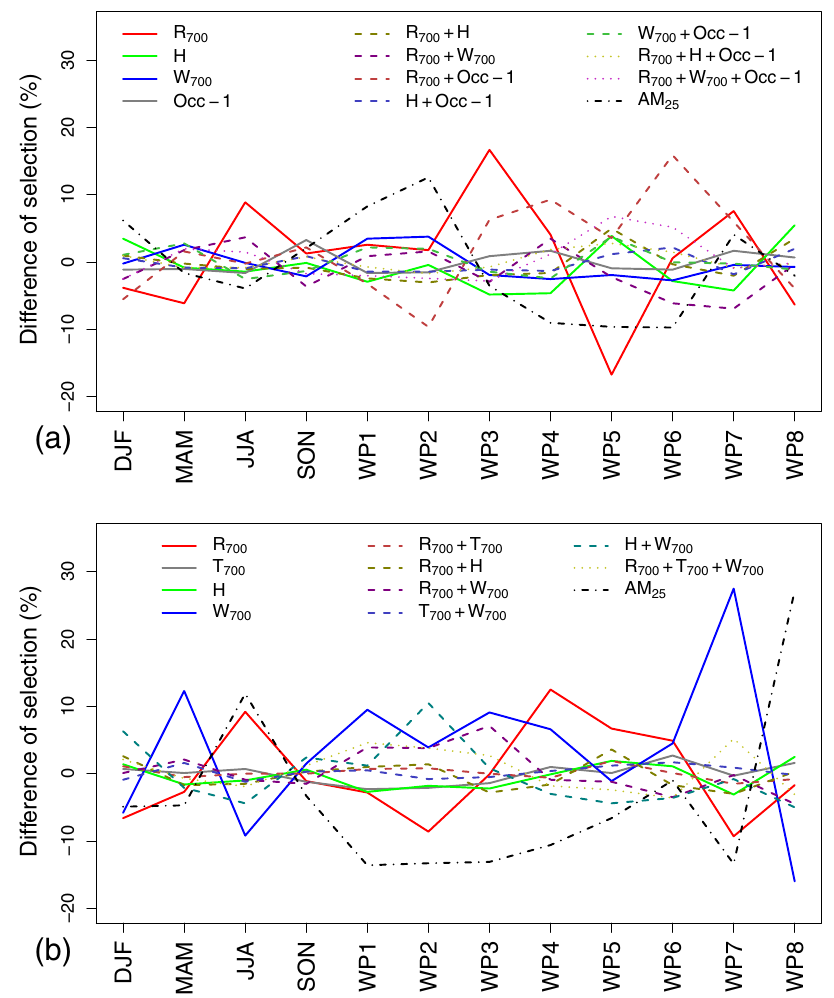
Figure 10. For each season and weather type, difference (%) in selection frequency with the all-days case for different regression structures. Results for the prediction of (a) occurrence and (b) amount. A positive difference indicates that the considered regressive structure is selected more often than for the all-day situation. Results are displayed for a grid cell located in the northwest of France. For a clearer illustration, the three or four regressive structures that are almost never selected are not displayed.